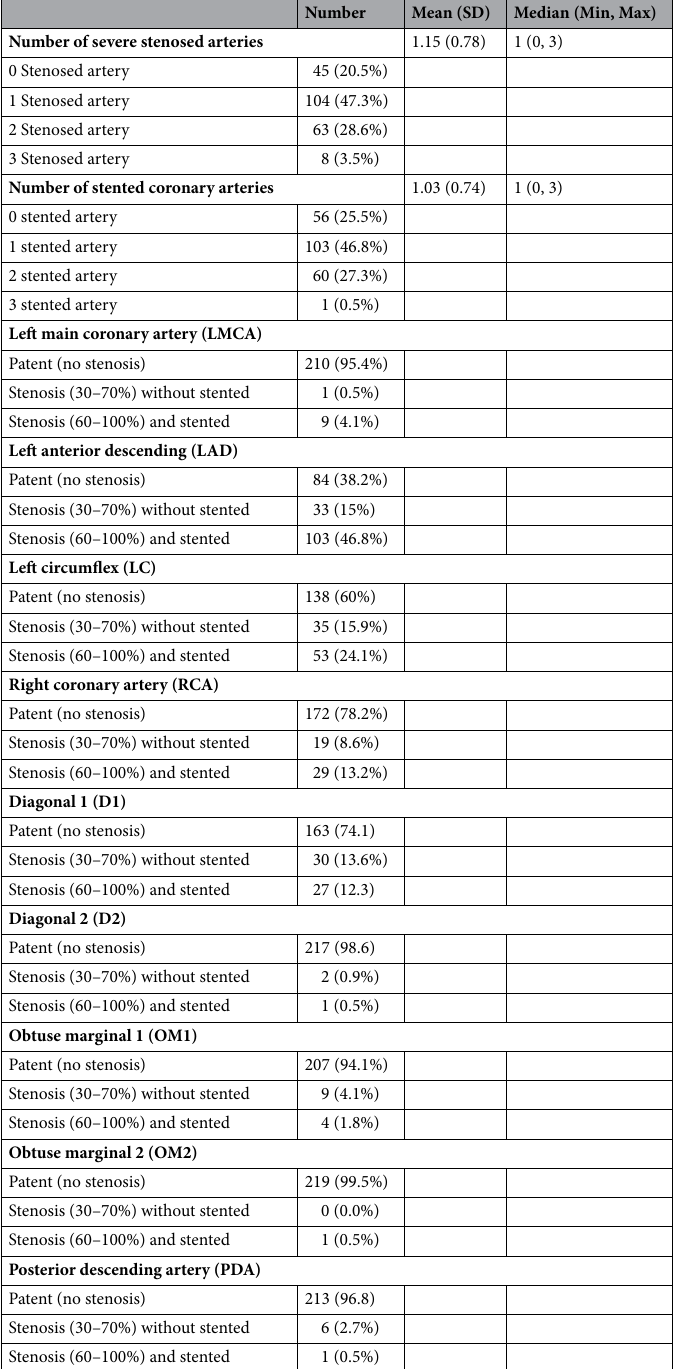
Table 2. Characteristics of CAD of the study participants ( N =